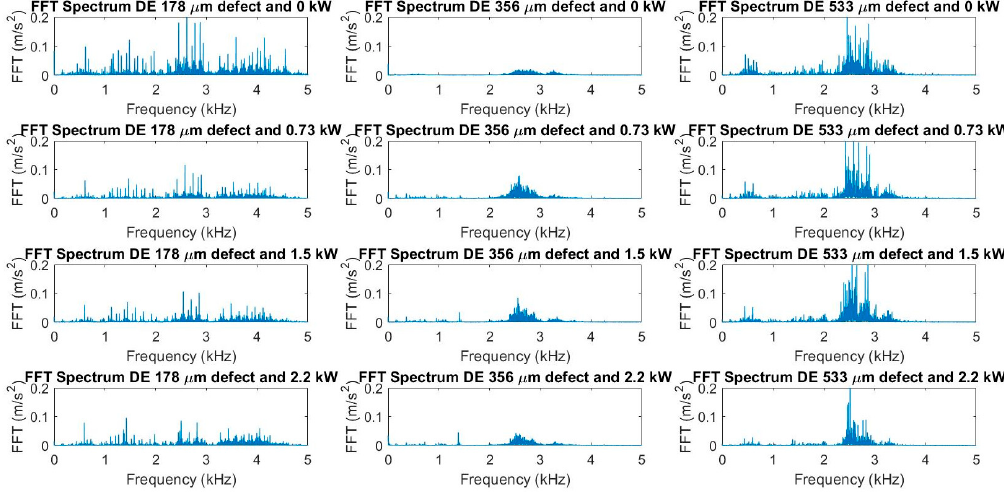
Figure 5. Fast Fourier-transform (FFT) raw spectra: vibration signals. DE: drive end.